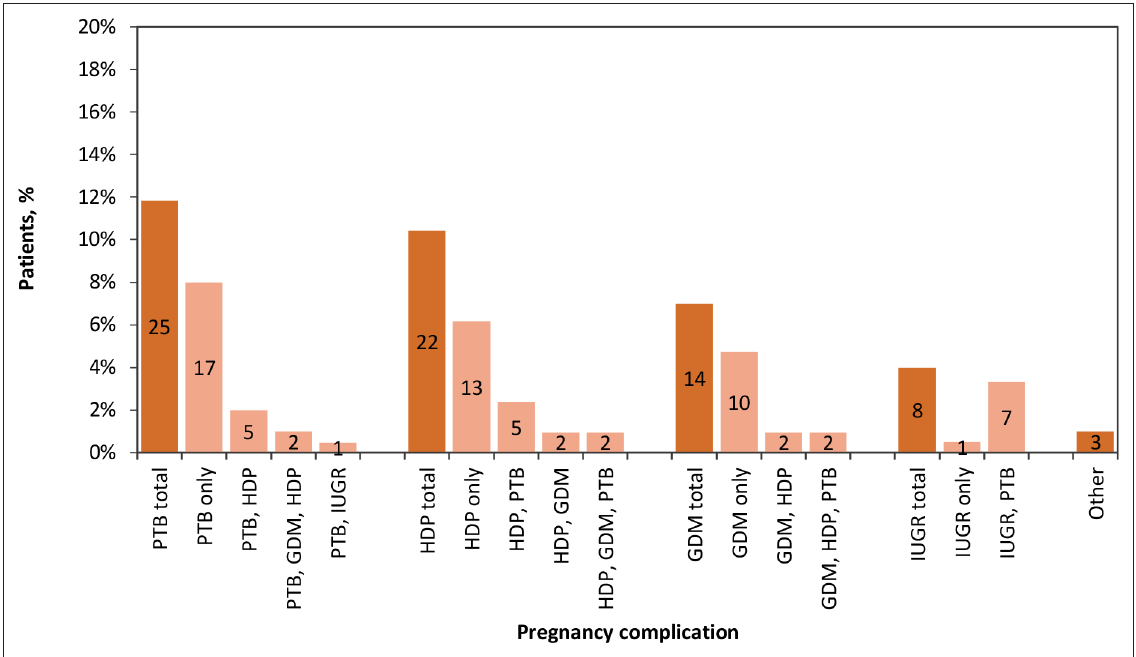
Figure 2 All pregnancy complications reported in survey and/or listed in the EMR of patients who consented to chart review ( n = 211). Number of patients specified as labels. GDM = gestational diabetes mellitus. HDP = hypertensive disorders of pregnancy. IUGR = intrauterine growth restriction. PTB = preterm birth.